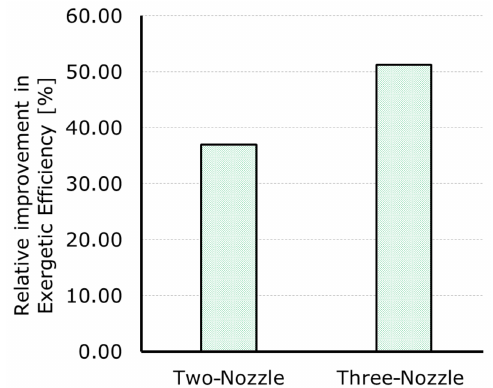
Figure 14. Relative improvement in exergetic